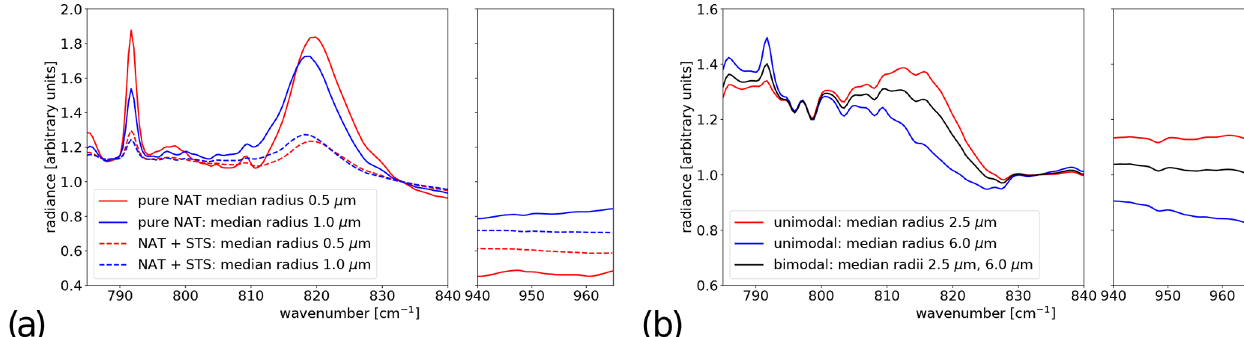
Figure 5. Selected spectra for NAT–STS mixed clouds (a) and bimodal NAT particle size distributions (b) . The spectra were scaled using the mean radiance in the 832.0–834.0cm − 1 spectral window such that the radiance for all spectra equals one in this window. (a) The solid lines show spectra for unimodal NAT particle size distributions. Red denotes a median radius of 0.5µm and 10ppbv HNO 3 , and blue denotes a median radius of 1.0µm and 10ppbv HNO 3 . The dashed lines show the NAT–STS mixed clouds. The amount of NAT is the same as for the pure NAT simulations, and the volume density of STS is 10µm 3 cm − 3 in both cases. (b) The red and blue lines show the spectra for unimodal size distributions with median radii of 2.5 and 6.0µm respectively. The amount of HNO 3 is 10ppbv in each case. The black line shows the simulation results for a bimodal size distribution with median radii of 2.5 and 6.0µm and 5ppbv HNO 3 in each